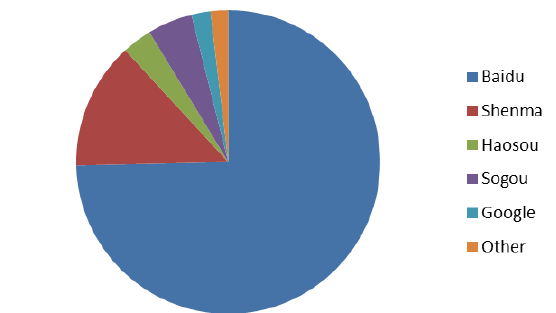
Figure 2. Market shares of search engines in China (Feb.